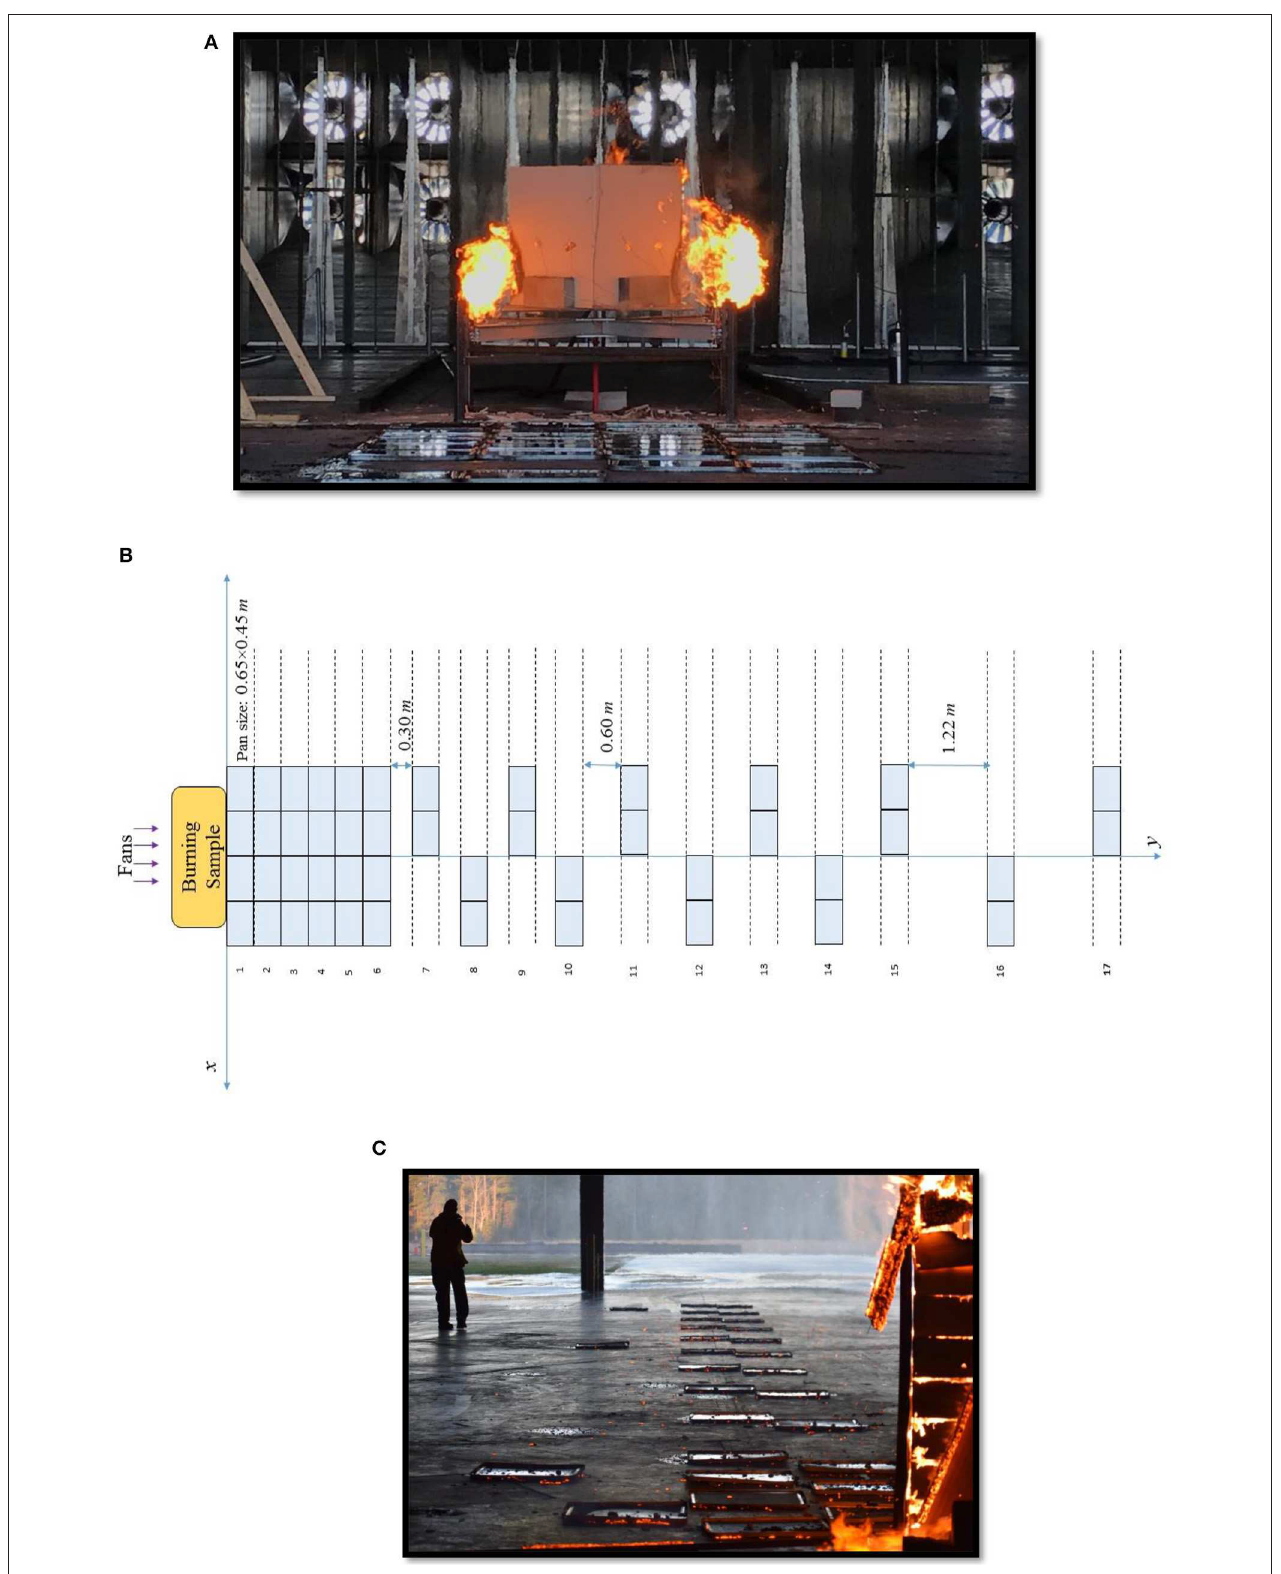
FIGURE 2 | (A) Burning sample (corner assembly) inside the wind tunnel. (B) Layout of the water pans. (C) Water pans downwind of fire.